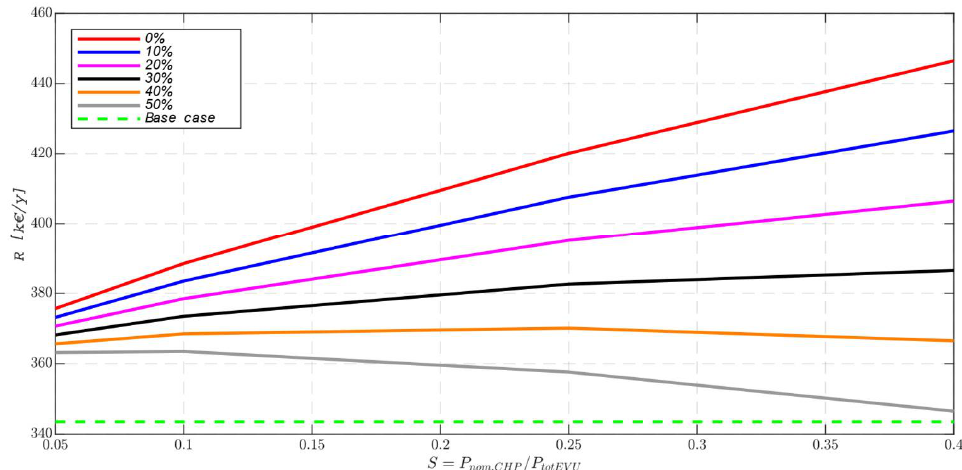
Figure 10. CHP power plant size and cost sensitivity analysis.